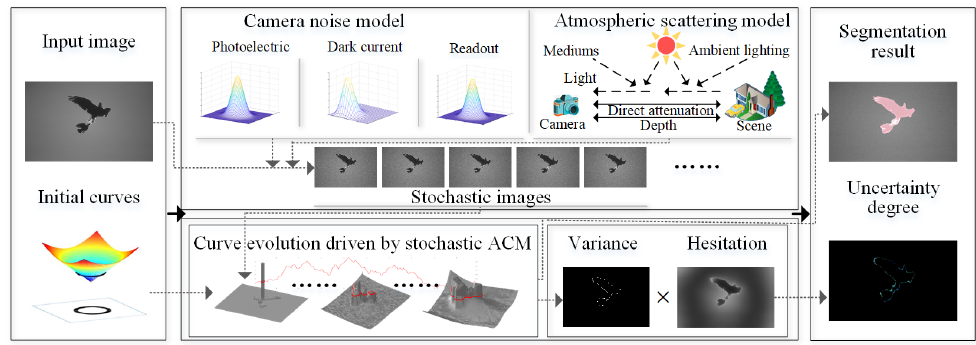
Figure 1. The block diagram of the proposed stochastic